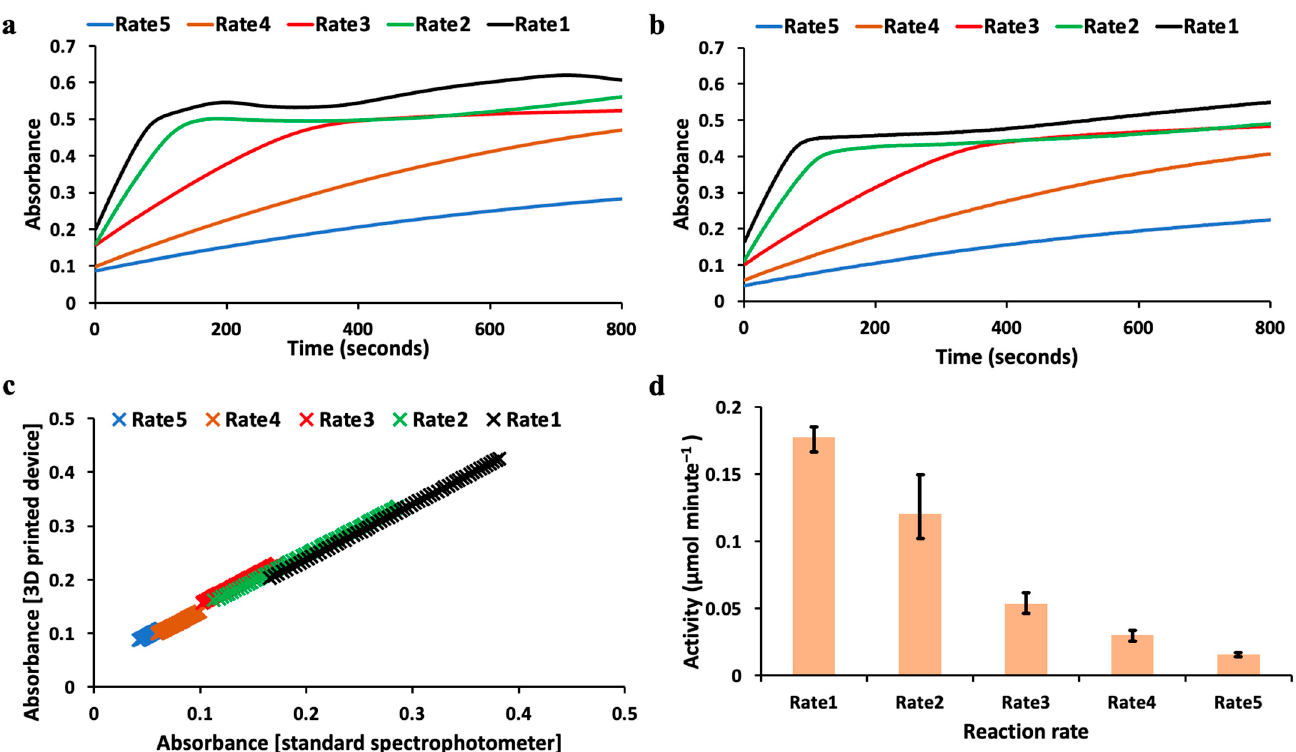
Figure 3. Enzyme kinetics measured at different reaction rates using the 3D-printed spectrophotometer and reference spectrophotometer are indicated. ( a ). Enzyme kinetics (average absorbance value vs. time) monitored using the reference table-top spectrophotometer. ( b ). Enzyme kinetics (average absorbance value vs. time) monitored using the 3D-printed spectrophotometer. ( c ). Correlation plots between the reference table-top spectrophotometer and the 3D printed spectrophotometer for the kinetics activity monitored at different reaction rates. Rate 1: y = 0.87 ∗ x; R 2 = 0.9995; Rate 2: y = 0.81 ∗ x; R 2 = 0.9981; Rate 3: y = 0.71 ∗ x; R 2 = 0.9984; Rate 4: y = 0.66 ∗ x; R 2 = 0.9977; Rate 5: y = 0.53 ∗ x; R 2 = 0.9978; ( d ) Activity calculated using the 3D-printed spectrophotometer at different reaction kinetics rates with error bars. All measurements were done in triplicate.